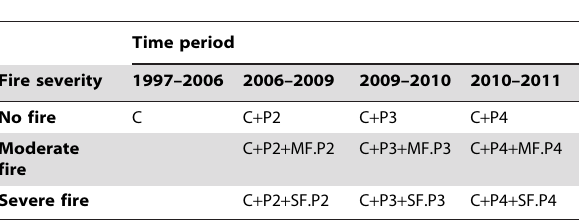
Figure 3. Temporal changes in the numbers of trees of different forms. The relative composition of populations of large trees with cavities in different forms ( sensu Figure 2) is shown for 1997–